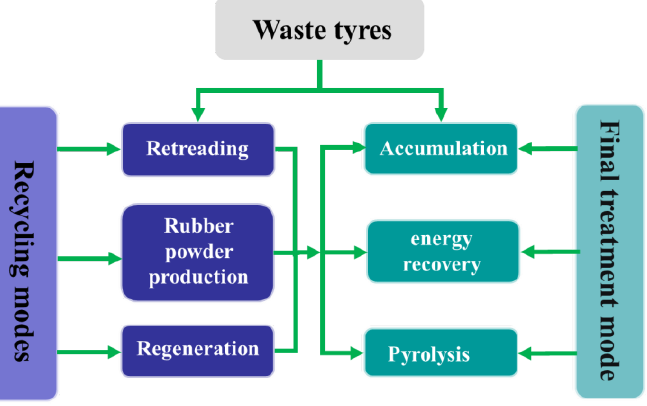
Figure 1. Main methods of WT treatment.